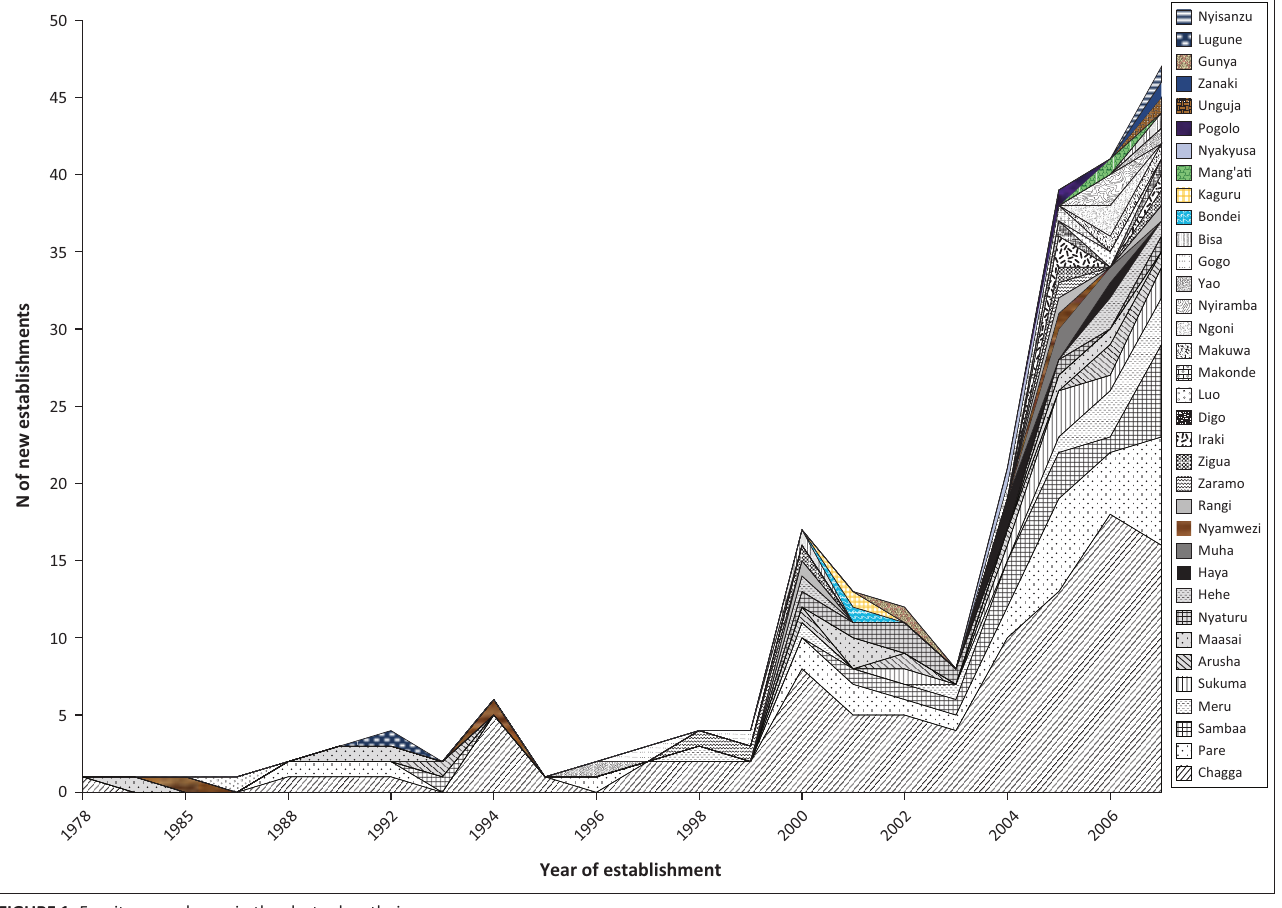
FIGURE 1: Furniture producers in the cluster by ethnic